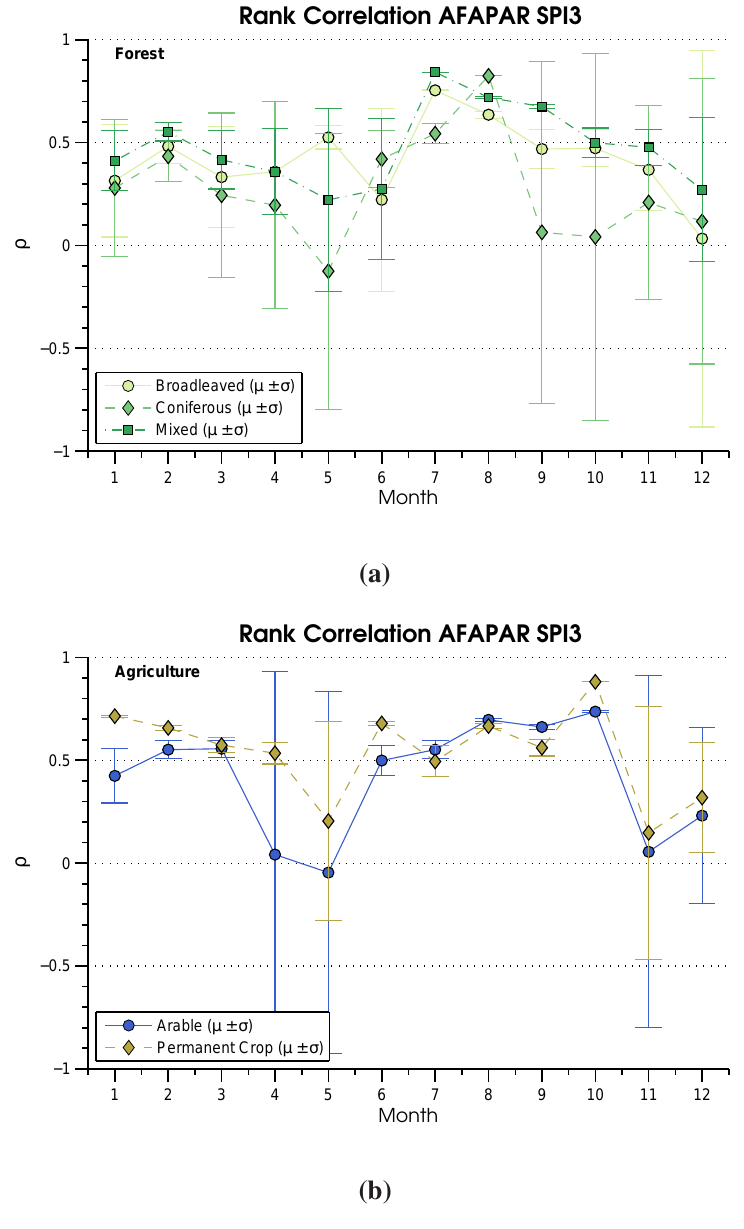
Spatial-averaged rank correlation ( µ ) and the corresponding spatial standard deviation ( σ ) between anomalies of FAPAR and SPI-3 for: ( a ) forest; and ( b ) agriculture land cover